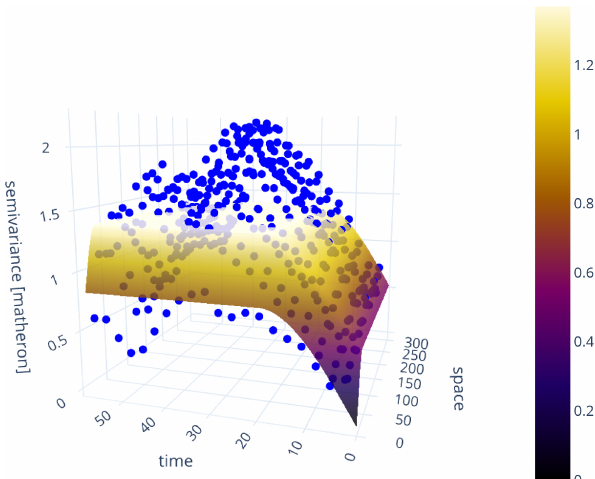
Figure 6. Default 3D scatterplot of a space-time variogram (blue points), with fitted product-sum model (surface). The variogram is estimated from the in situ soil temperature measurements at 20cm depth (WSN product, Wireless Sensor Network) published in Fer- sch et al. (2020). To decrease the computational workload, only ev- ery sixth measurement was taken from the time